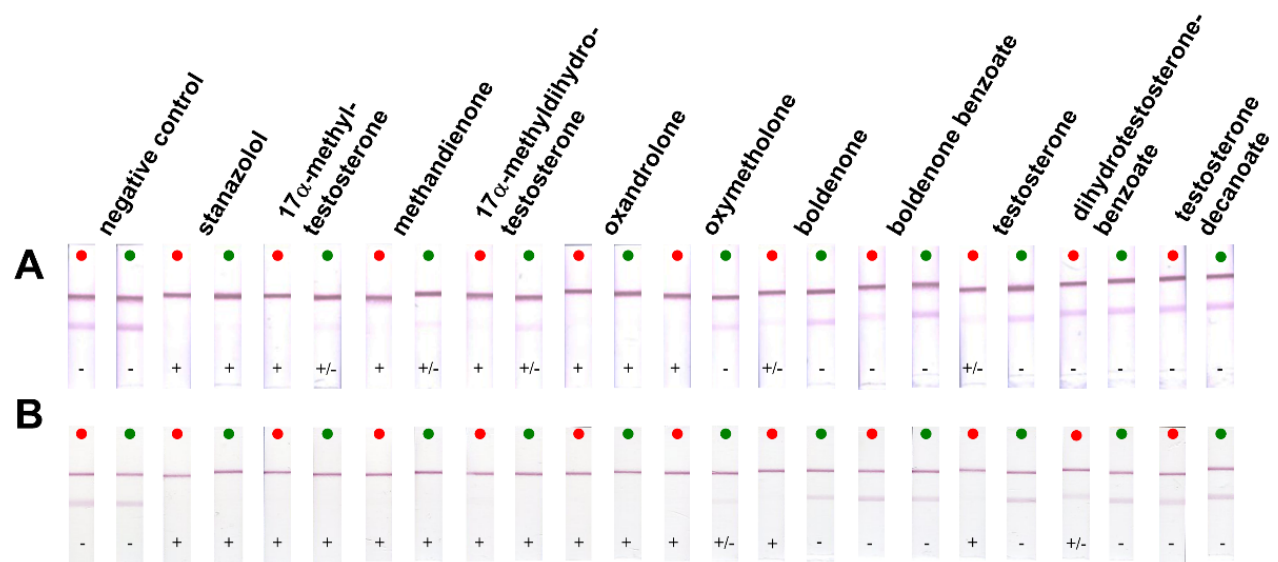
Figure 3. Cross-reactivity of selected steroids (Figure 1 and Supplementary Figure S3) in indirect (panel ( A )) and direct format (panel ( B )) tested at 10 µ g/mL (red dot) and 0.1 µ g/mL (green dot). The tests were evaluated as negative ( − ), suspect (+/ − ) or positive